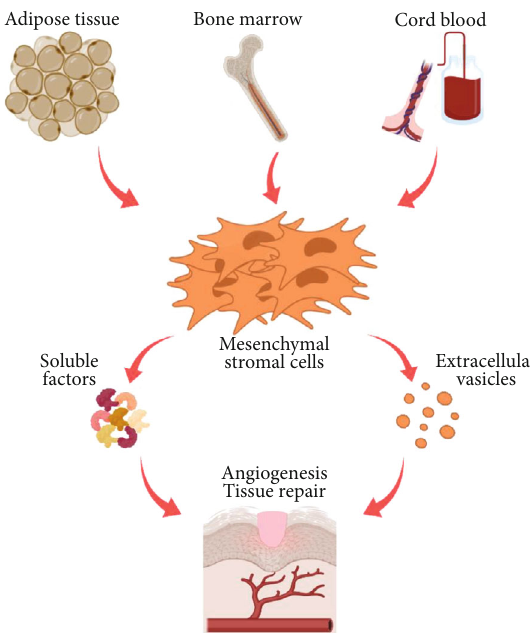
Figure 1: MSCs isolated and expanded from the most common sources (AT, BM, and CB) release their secretome in vitro and in vivo which acts upon mechanisms responsible for enhancing tissue repair and